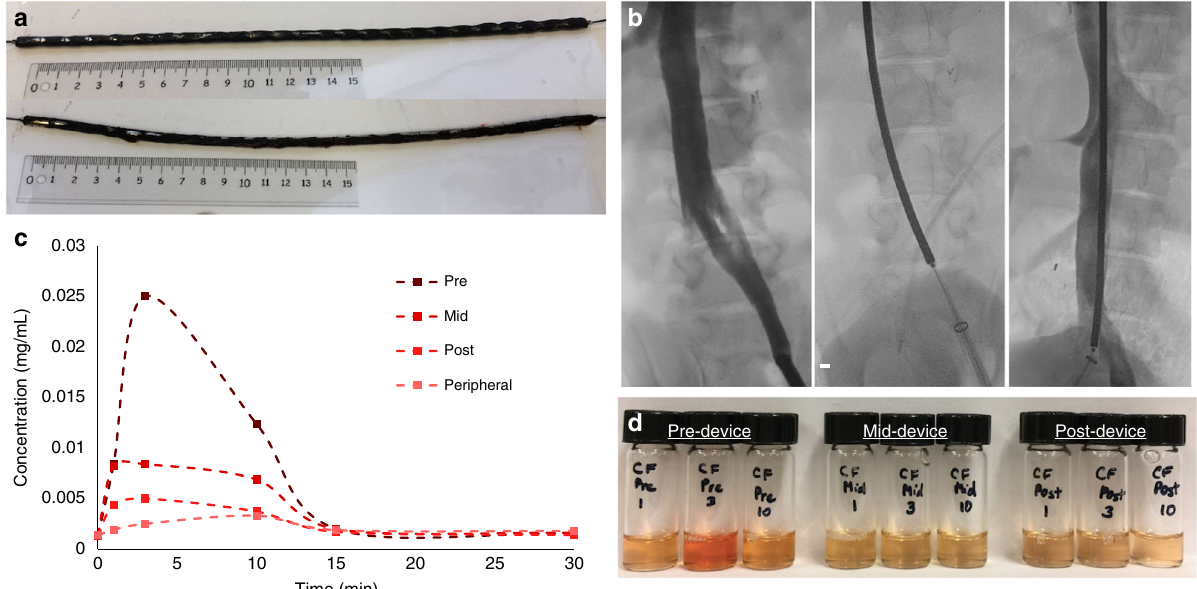
Fig. 5 In vivo results. a Device containing 25 magnets (1 cm× 0.5 cm) with IONP-HN3-DNA coating (above), and the same device after the in vivo experiment (below), demonstrating minimal loss of particles after removal of the device. b Fluoroscopy images during in vivo porcine experiment demonstrating the inferior vena cava with opaci fi ed right renal veins (scale bar = 5 mm). The device was placed within the inferior vena cava. The sampling catheters were placed immediately proximal to the device, prior to the renal vein, and distal to the device. c DOX concentration measurements from pre- device, mid-device, post-device, and peripheral locations. d Plasma solutions from the experiment described in c : Left 3, pre- fi lter samples taken at 1, 3, and 10 min; Center 3, mid- fi lter samples taken at 1, 3, and 10 min; Right 3, post- fi lter samples taken at 1, 3, and 10